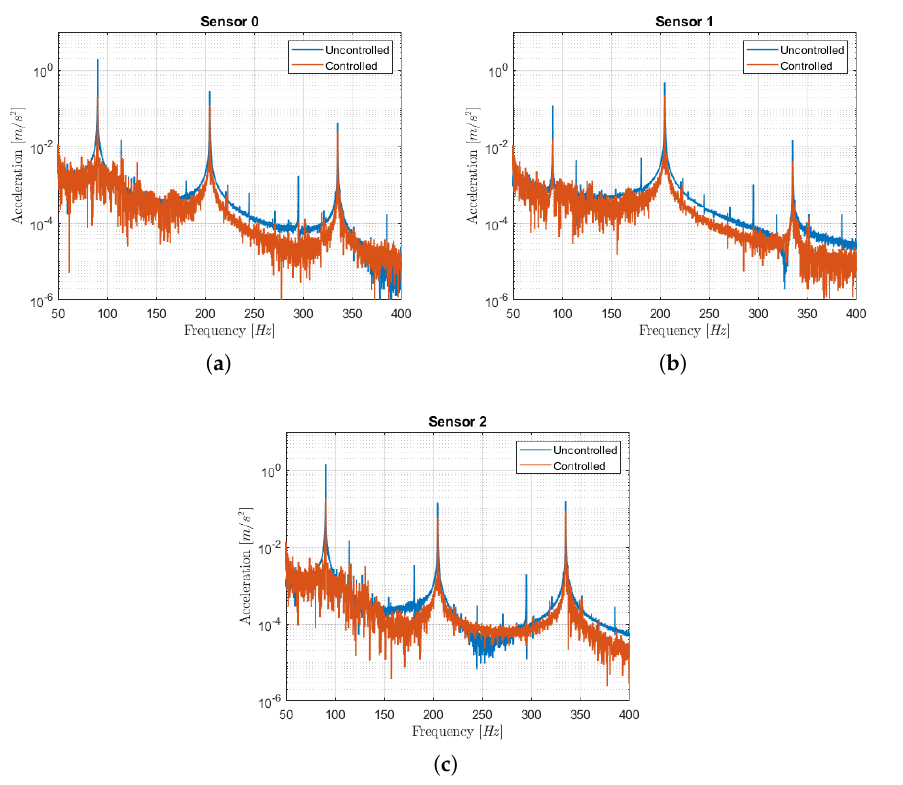
Figure 7. Comparison between uncontrolled (blue line) and controlled (red line) system for the three sensors in the experimental